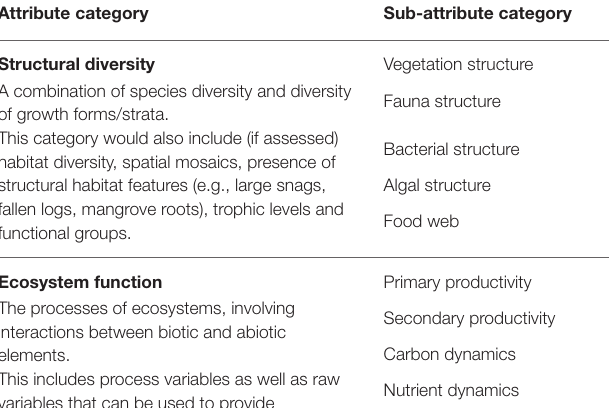
TABLE 1 | List of attributes and sub-attributes classification for coastal wetlands restoration assessment